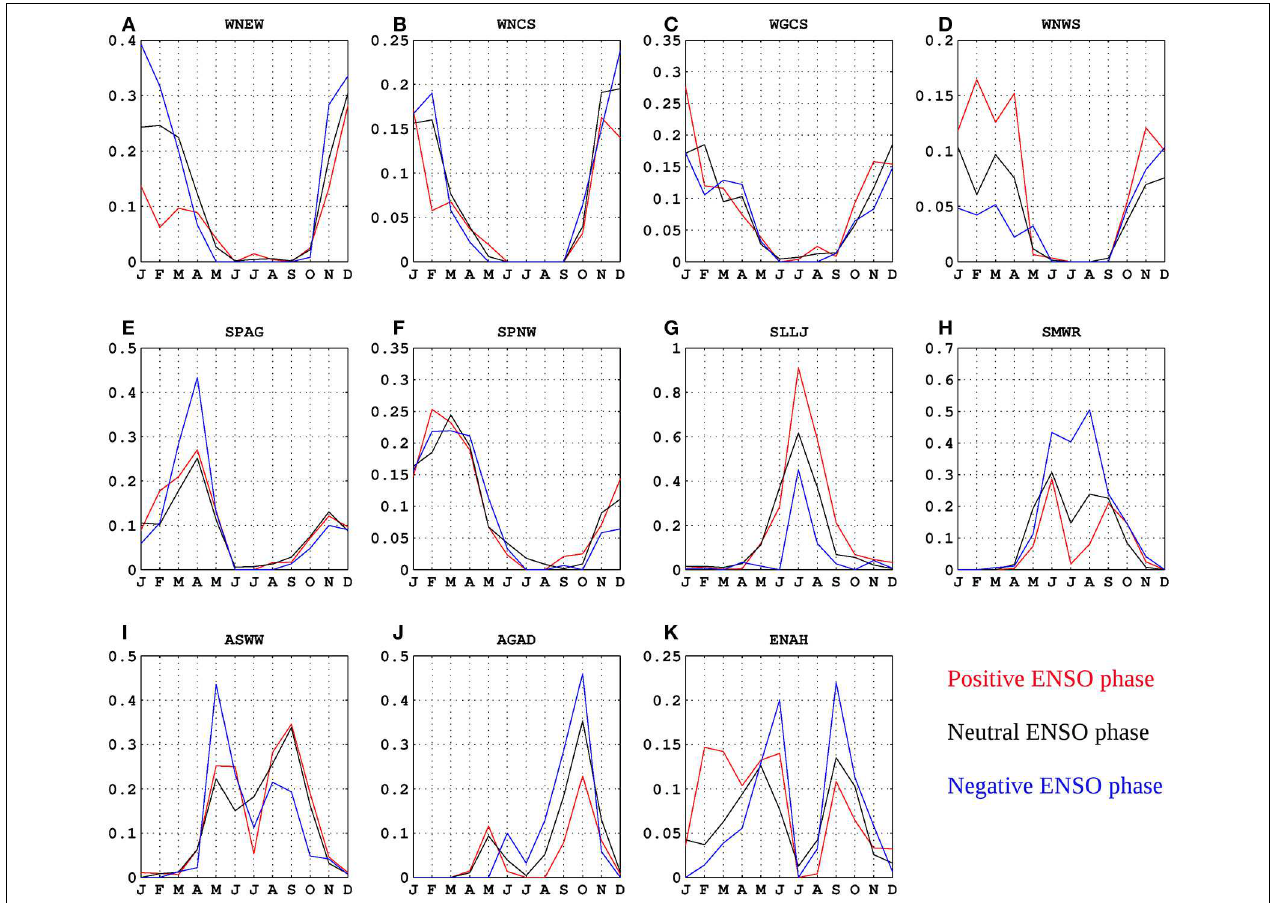
FIGURE 10 | Monthly probabilities of occurrence under each ENSO phase for every regime. Ordinate axis scales are not the same for every